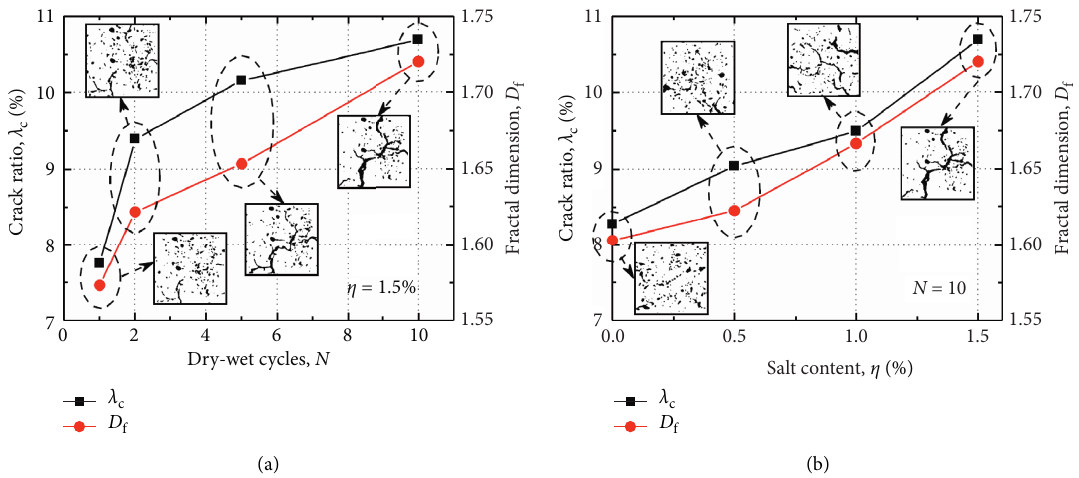
Figure 17: Quantified indexes for crack network. (a) Effect of dry-wet cycles. (b) Effect of salt content.